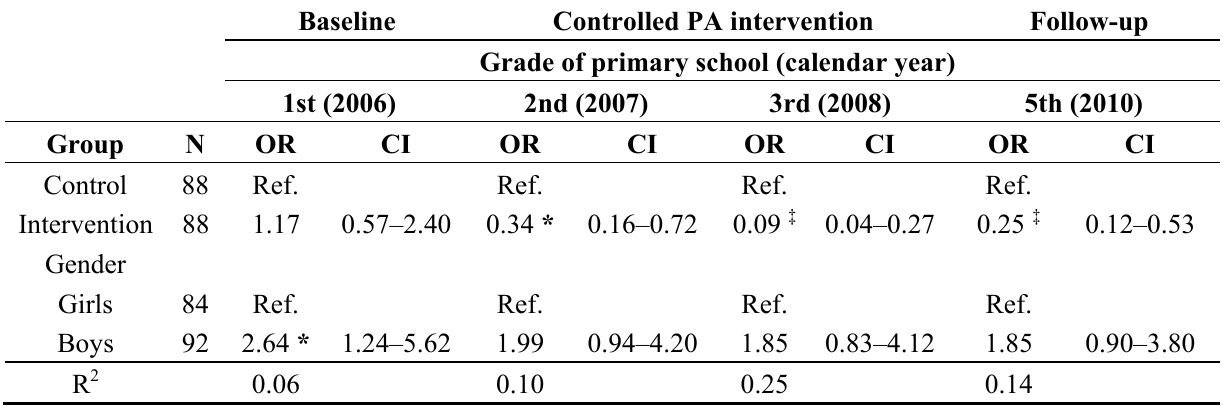
Table 3. Impact of participation in intervention programme on the odds of child obesity/overweight during